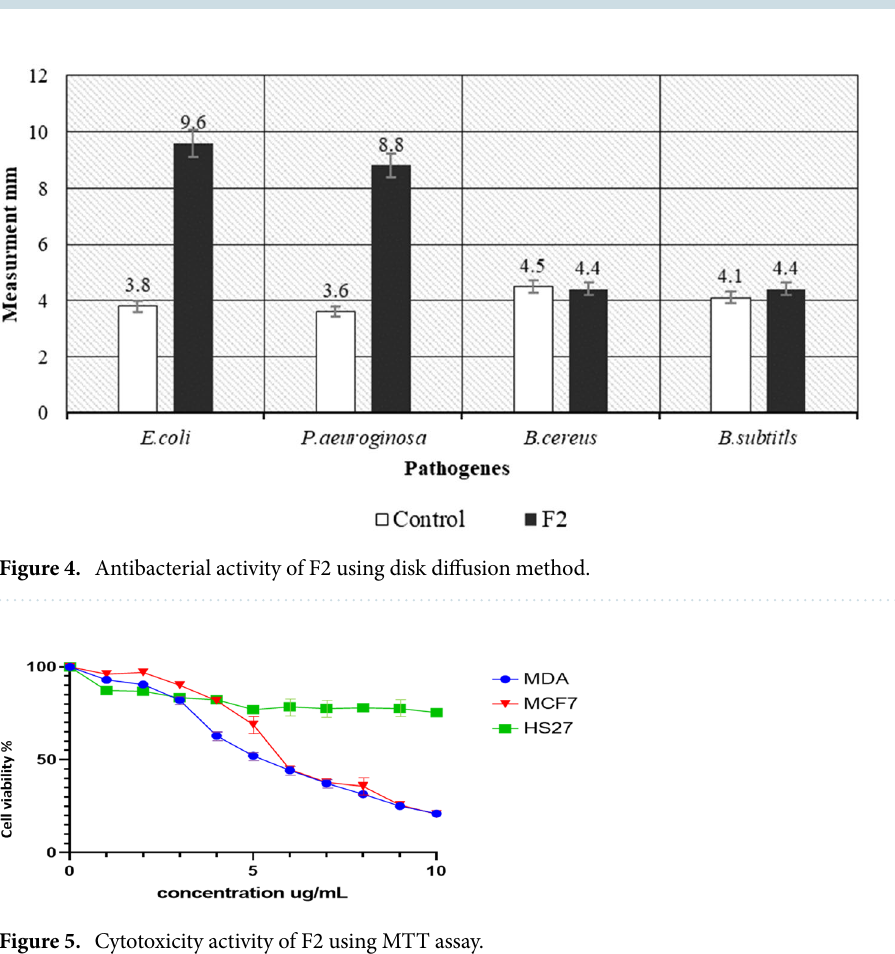
Figure 5. Cytotoxicity activity of F2 using MTT